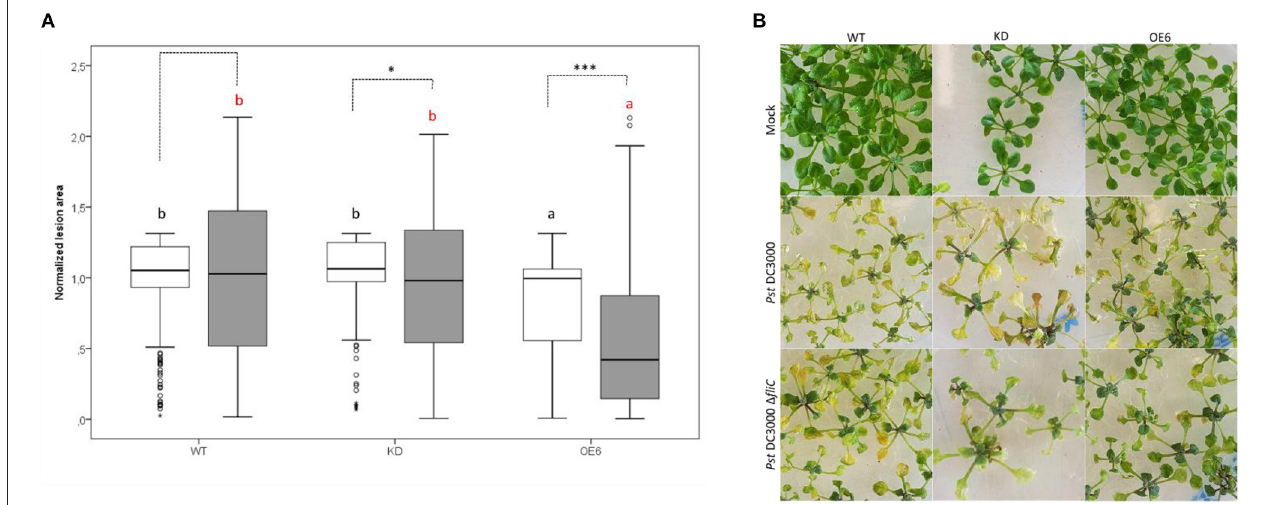
FIGURE 8 | Damaged leaf area after Pst DC3000 1 fliC mutant infection in WT, OE6, and KD plants and comparison with Pst DC3000 strain. Quantification of lesion area (A) . The leaf damage was measured as chlorotic lesion area in total leaf area and normalized to the WT lesion area. These results are based on three independent biological replicates. For this graph, values of all plant lines and treatments were normalized to the WT of each experiment, allowing us to represent two different experiments together in one graph. White boxes represent Pst DC3000 infected plants and gray boxes 1 fliC -infected plants. Comparison of Arabidopsis lines within Pst DC3000 treated plants (black letters) or 1 fliC infected plants (red letters) was done with a one-way ANOVA analysis followed by a post hoc Tukey test. Significant letters indicate differences at a level of p < 0.05. Comparing mock and Pst DC3000 infected plants within a plant genotype was done using independent samples T -test for normally distributed data and Mann–Whitney test for non-normally distributed samples. Asterisks indicate statistically significant differences between treatments within the same transgenic line (* p ≤ 0.1; *** p ≤ 0.001). Phenotype of Arabidopsis lines after mock treatment and infection with Pst DC3000 and 1 fliC mutant (B)